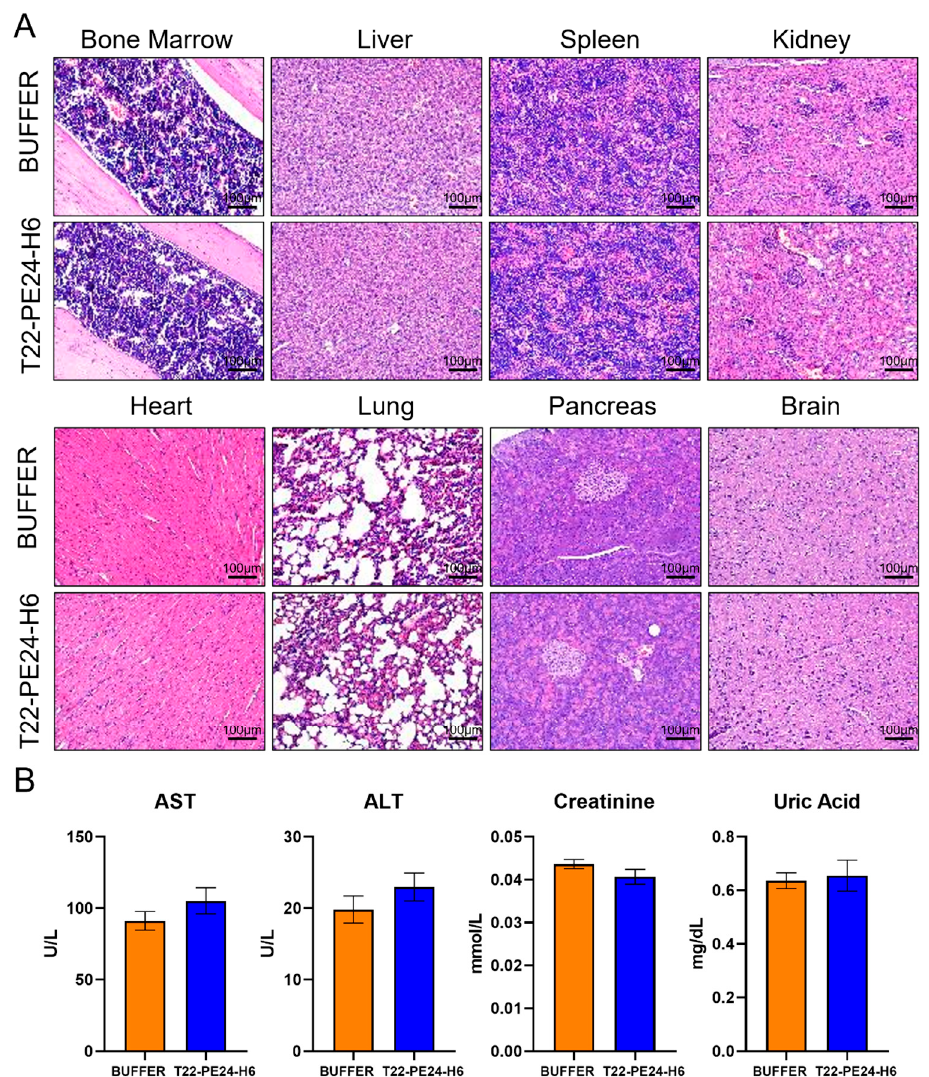
Figure 4. Evaluation of T22-PE24-H6-induced toxicity. ( A ) H&E staining of the BM, liver, spleen, kidney, heart, lung, pancreas, and brain after T22-PE24-H6 or buffer treatment. ( B ) AST, ALT, uric acid, and creatinine levels in plasma comparing the BUFFER and T22-PE24-H6 mouse groups. Original magnification ×200 for panel A. Statistical analysis performed by the Mann-Whitney U test. The results are expressed as mean ± SEM. AST: aspartate aminotransferase; ALT: alanine aminotransferase.